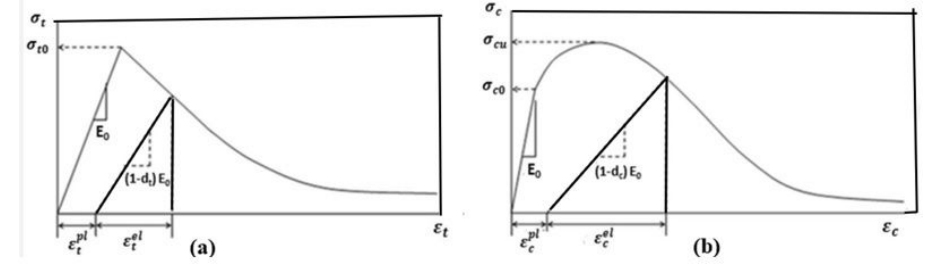
Figure 16: Damage variables: (a) in tension, (b) in compression, adopted from Birtel and Mark